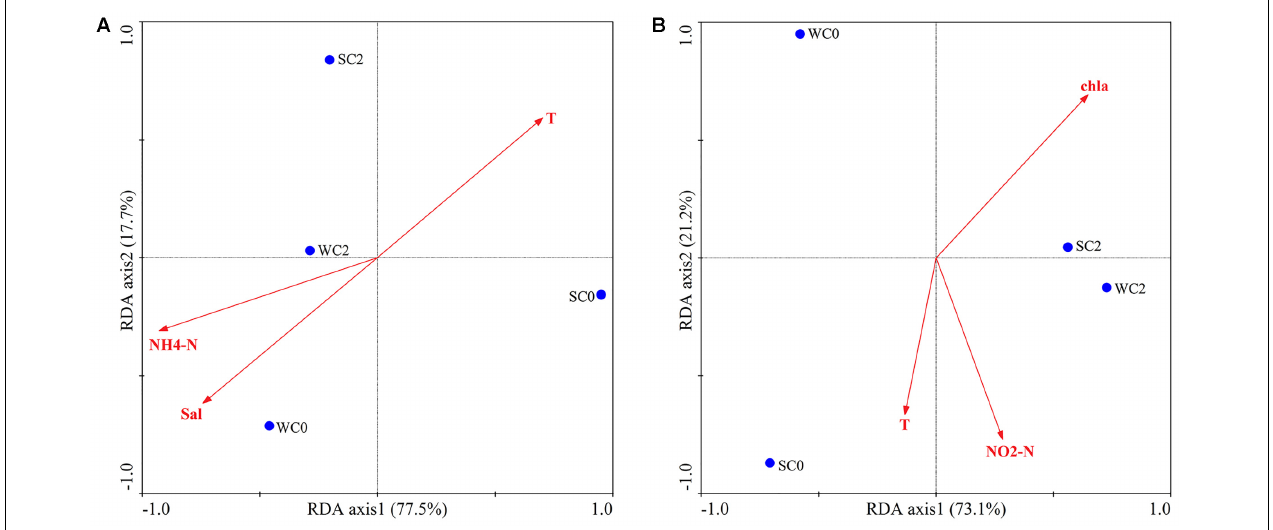
FIGURE 6 | RDA ordination plots for the relationships between AOA (A) and AOB (B) communities and environmental factors.